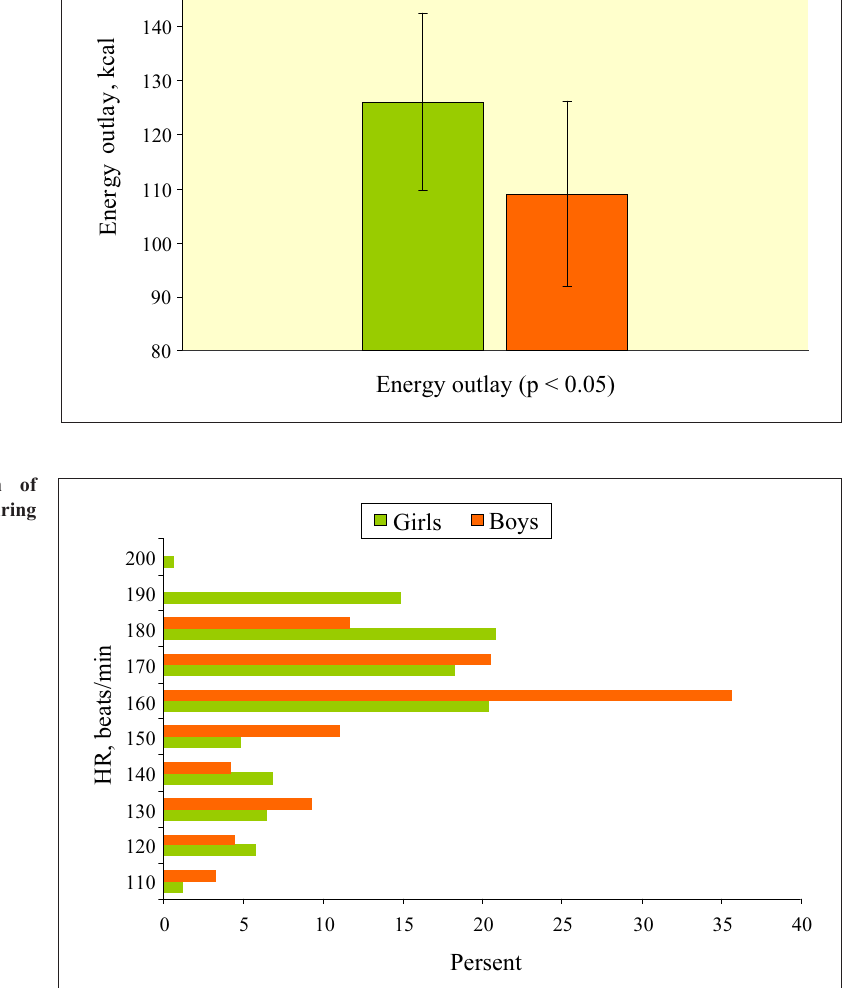
Figure 6. Percentage distribution of juvenile sports dancers’ heart rate during 10 min Latin